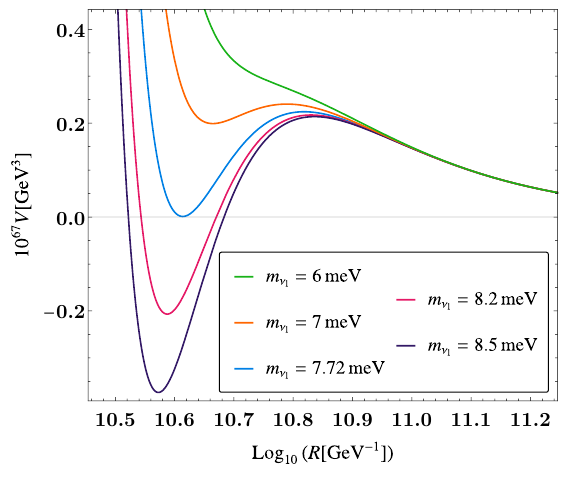
Figure 1 . The radion scalar potential for different values of the lightest Dirac neutrino